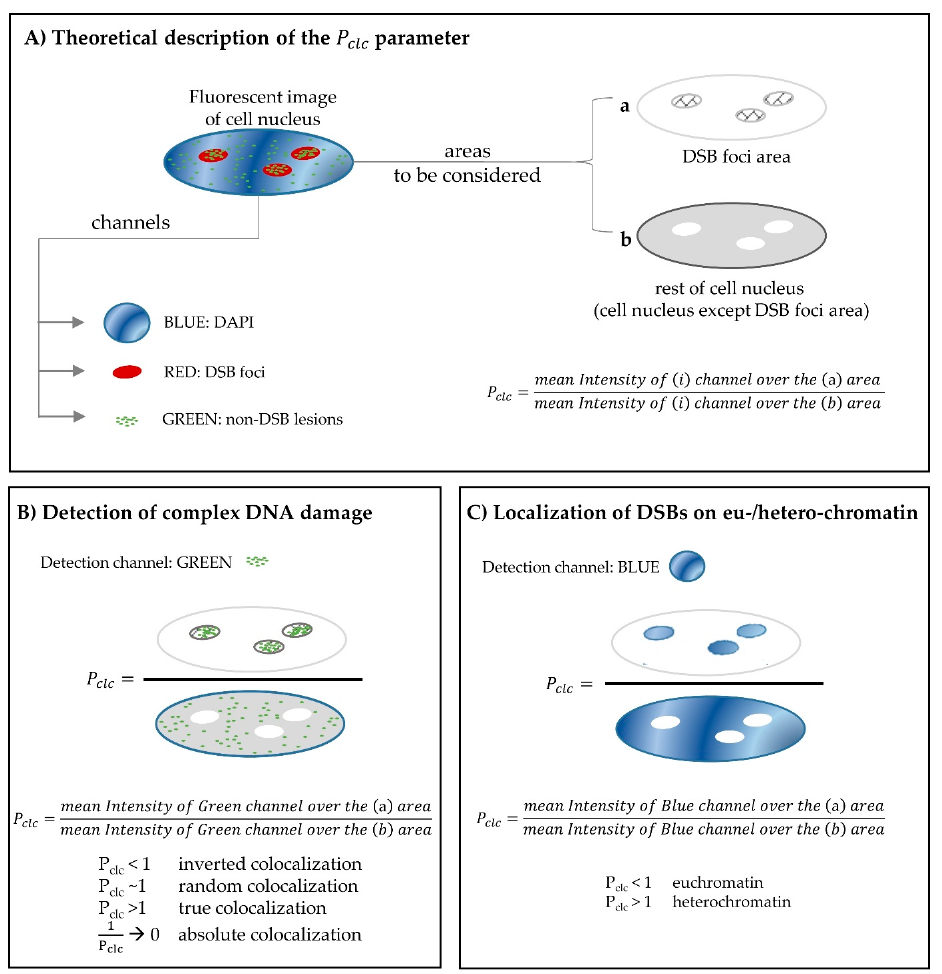
Figure 1. Optimization of fluorescence microscopy and colocalization assays for detection of complex DNA damage. ( A ) Theoretical description of the Pclc parameter [64]: An RGB fluorescent image can be split into three channels (Blue: DAPI, Red:DSB foci and Green: non-DSB lesions), and can also be considered as consisting of two geometrical areas: (a) the DSB foci area and (b) the rest of cell nucleus, i.e., the cell nucleus area after the exclusion of DSB foci area. The colocalization parameter Pclc examines the mean Intensity of a given fluorescent channel (i) considered over the DSB foci area, with its mean Intensity considered over the rest of the cell nucleus. ( B ) Detection of complex DNA damage: Complex DNA damage can be detected by considering the mean Intensity of the channel that corresponds to non-DSB lesions (Green channel here) for the calculation of Pclc parameter. Any Pclc values significantly greater than 1 imply true colocalization and subsequently enable the detection of complex DNA lesions. ( C ) An additional suggested application of Pclc parameter-localization of DSBs on eu-/hetero-chromatin: Mean intensity of DAPI channel (blue) over the DSBs area divided by the mean intensity of the same channel over the rest of cell nucleus (after excluding any nucleoli areas). Pclc values less than 1 imply DSB foci localization on euchromatin DNA regions, where the DAPI intensity is expected to be lower. In each case, measurement of lesions is being performed indirectly by the use of DNA damage/repair proteins specific primary antibodies (e.g., against γ -H2AX:DSB or OGG1:oxidized purines etc.) detected by the appropriate fluorescent labelled secondary antibodies as described in the